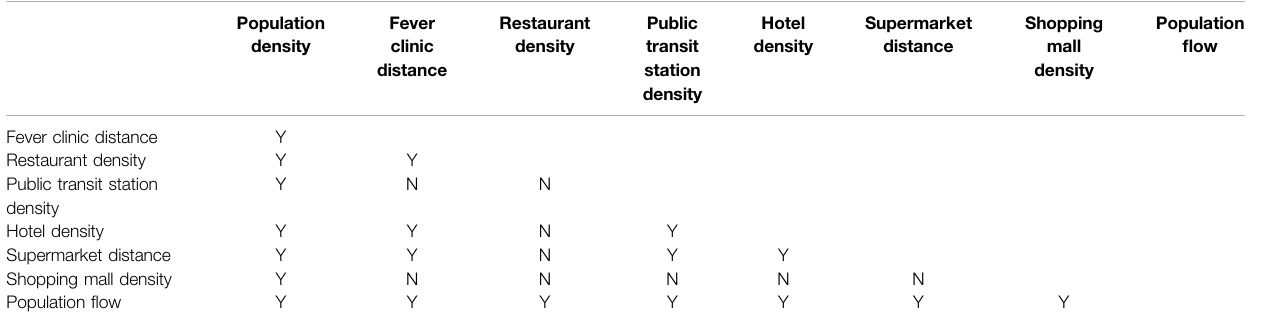
TABLE 4 | Ecological